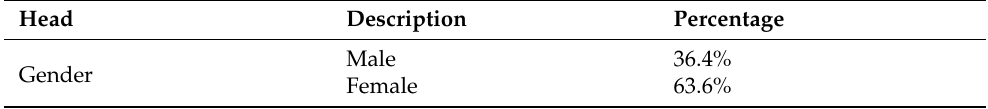
Table 1. Descriptive Statistics of